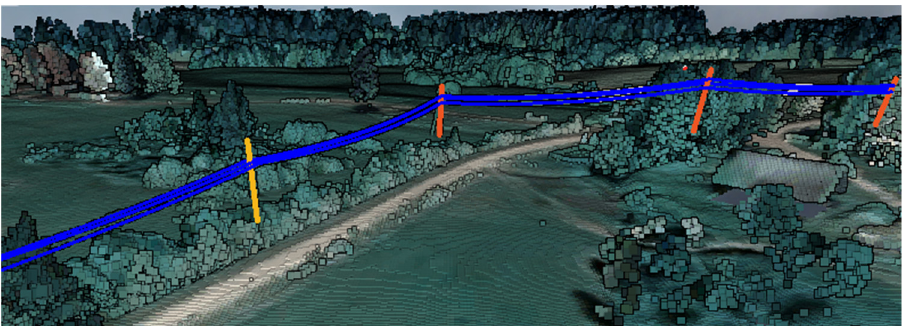
Figure 11. Fragment of an aerial laser scanning power